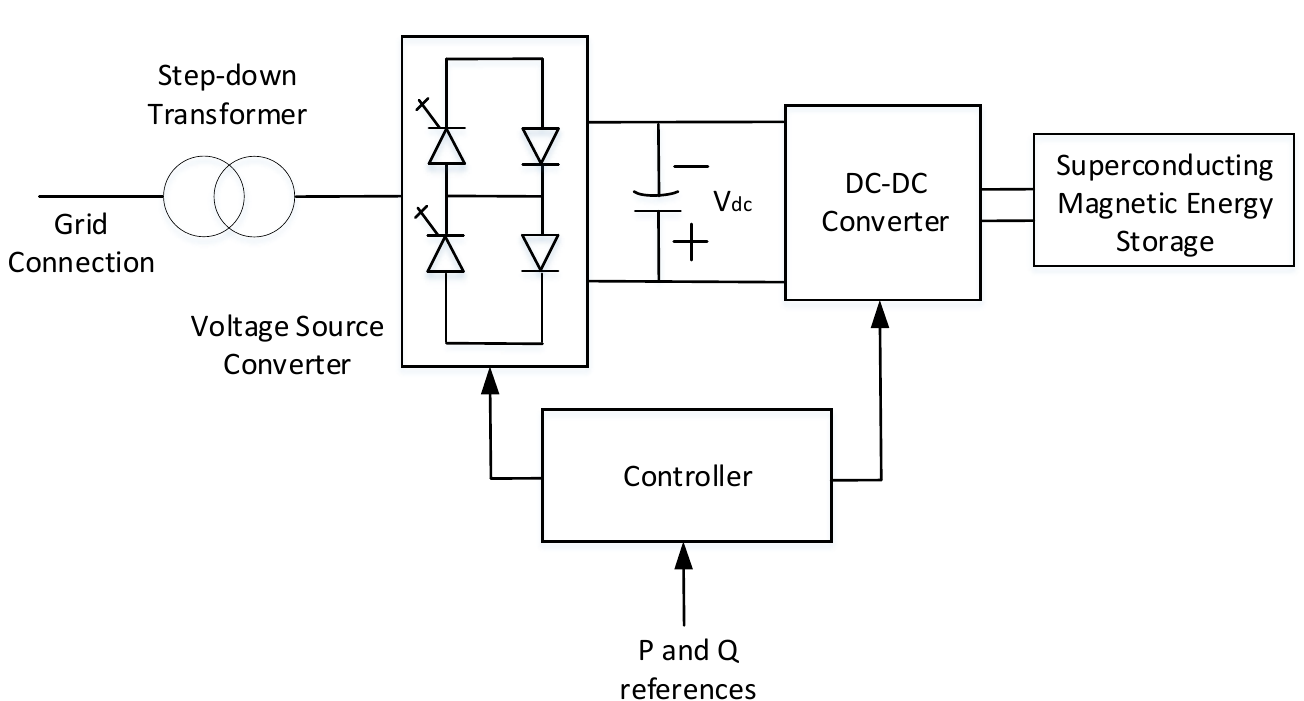
Figure 6. Block diagram representation of the static synchronous